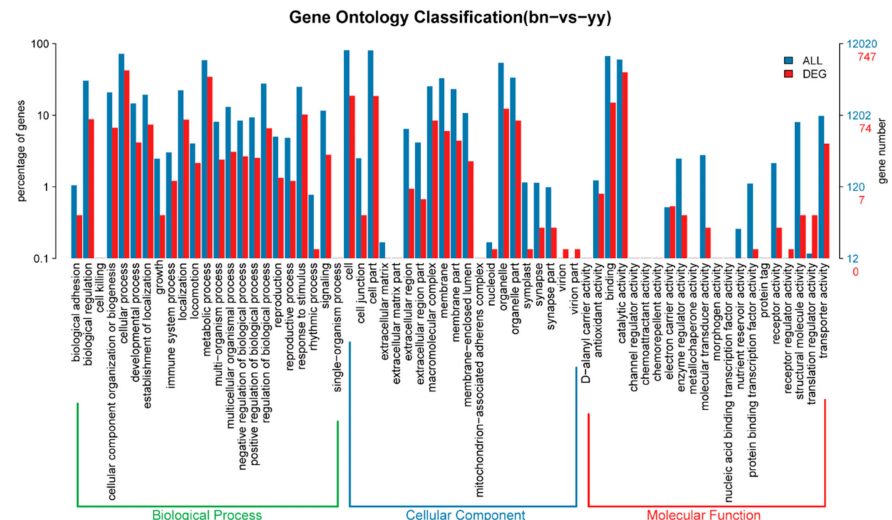
Figure 6. The distribution comparison of DEMs target genes and genes at GO Level2. Blue indicates all genes (ALL) entries at GO Level 2, red indicates the GO Level 2 entries enriched by DEMs target genes (DEG). The horizontal axis and the vertical axis are the entry name and the number of genes corresponding to the entry and its percentage.